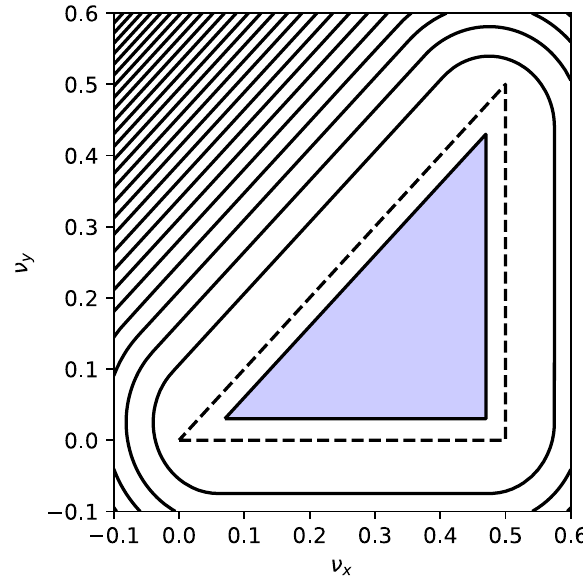
FIG. 1. The isolines of the function g from Sec. II B 1. The dashed lines show the resonance triangle. The blue area denotes the triangle with margins, which is derived from the resonance triangle using a margin of 0.025. Inside this blue area g vanishes. Outside of it g > 0 grows quadratically with the distance to that